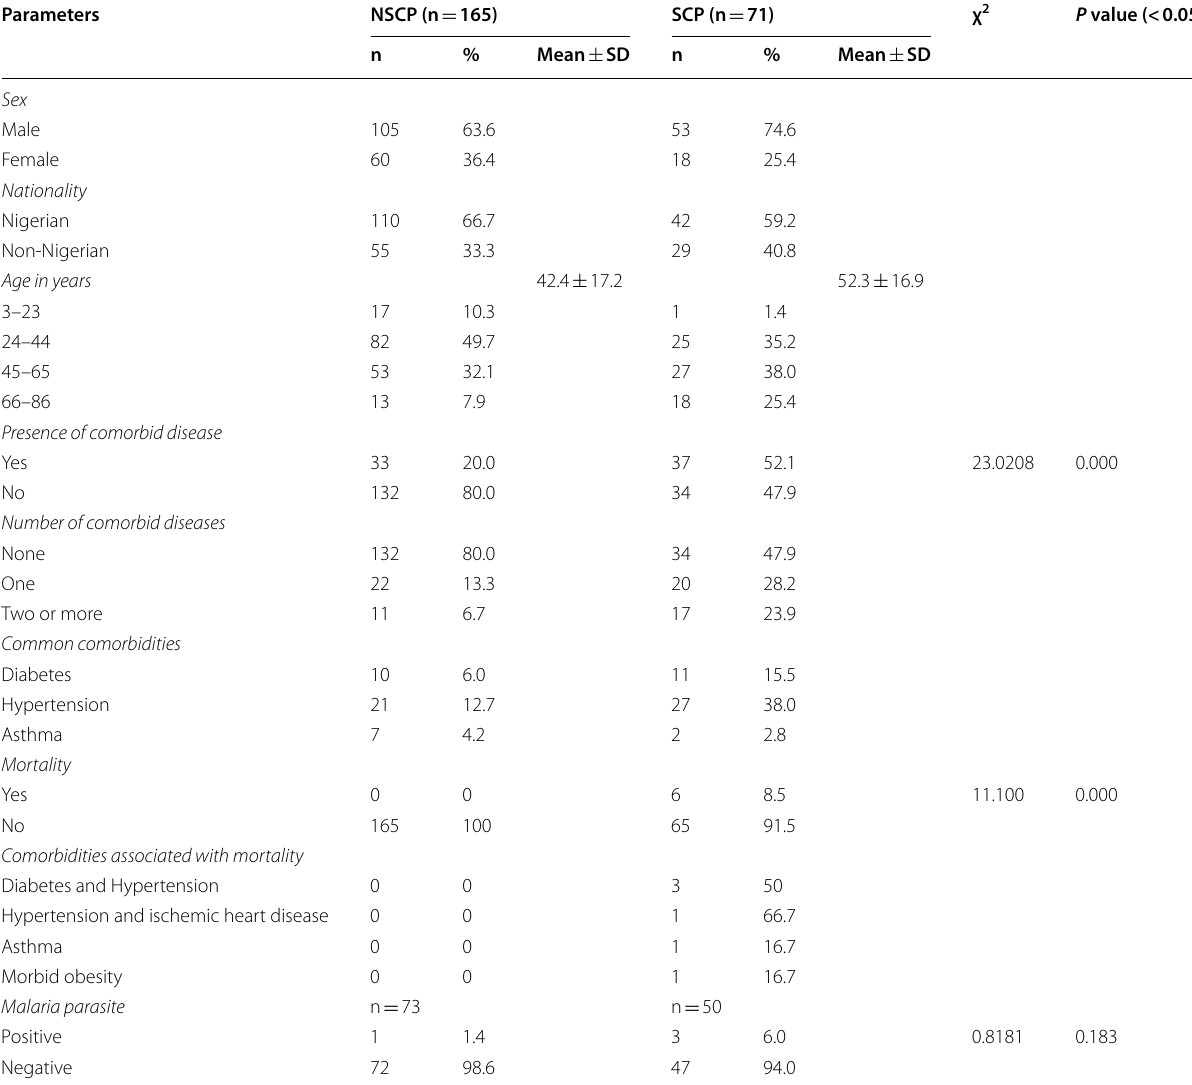
SCP patients with severe COVID-19, NSCP patients with non-severe COVID-19 The P value is provided for comparison between the NSCP and SCP